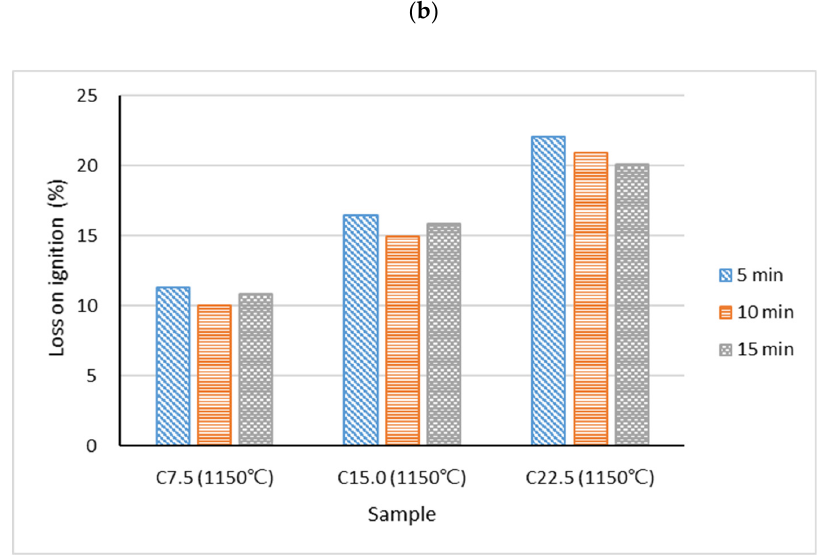
Figure 8. Loss on ignition of lightweight aggregates at Stage II mixed with ( a ) Industrial Sludge A, ( b ) Industrial Sludge B, and ( c ) Industrial Sludge C. ( b ) Industrial Sludge B, and ( c ) Industrial Sludge